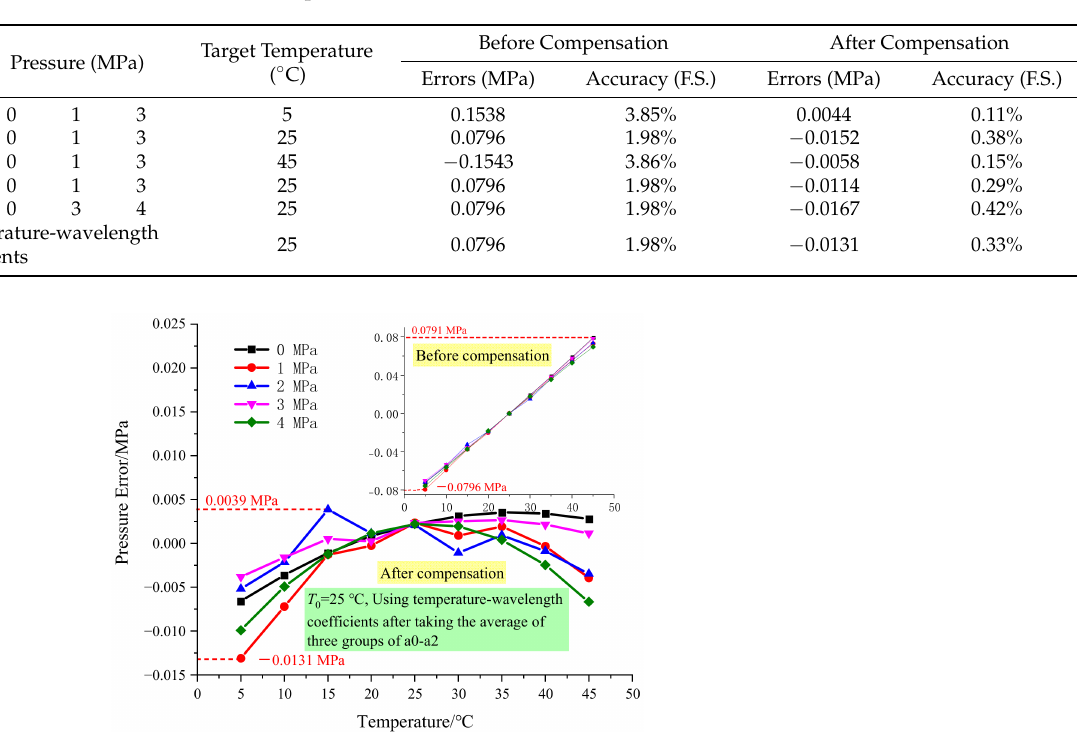
Table 1. Errors comparison with different data.